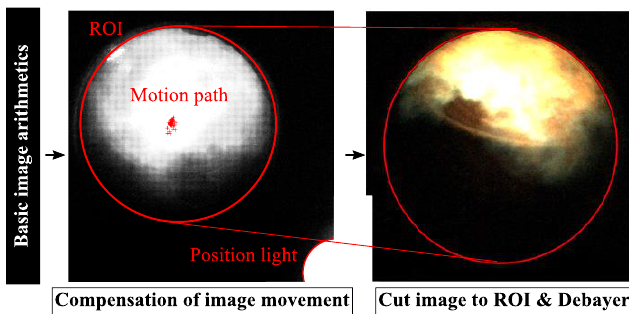
Figure 8. Preprocessing of images.